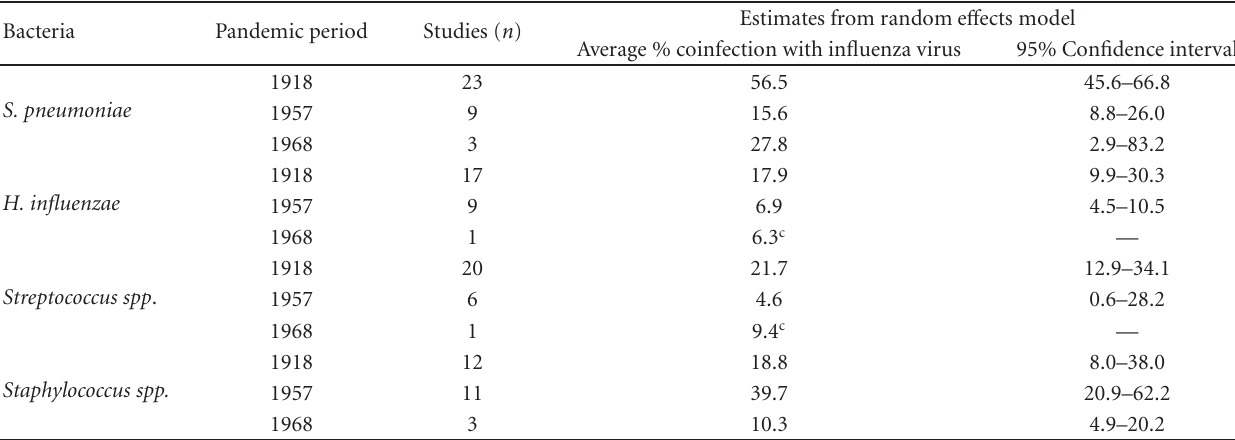
Streptococcus spp